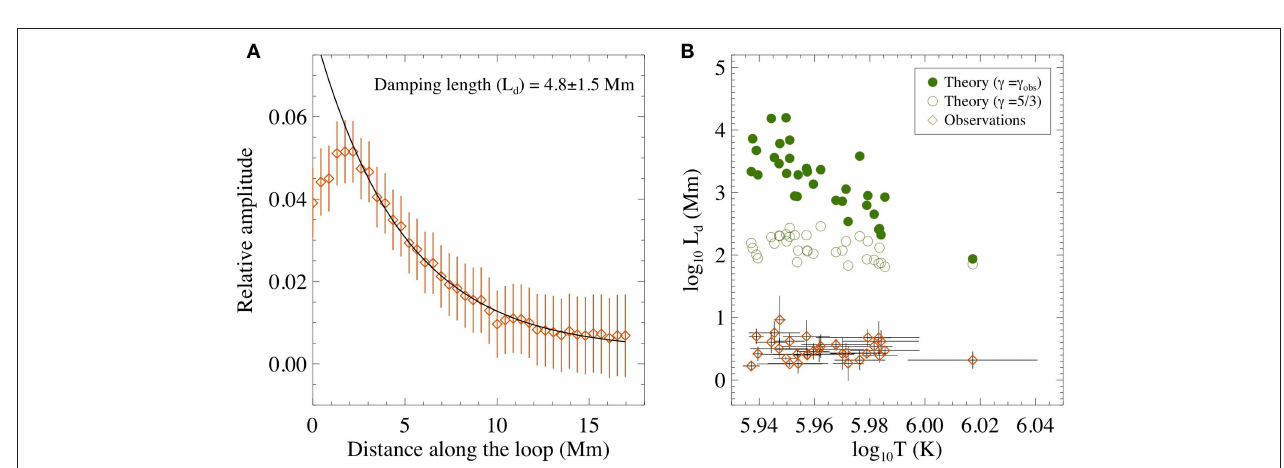
FIGURE 3 | (A) Relative amplitudes of the oscillations as a function of distance along the loop segment marked by the solid blue lines in Figure 1a . The vertical bars denote the respective uncertainties. The black solid line represents an exponential fit to the decaying phase of the data following Equation (2). The obtained damping length value from the fitted curve is listed in the plot. (B) Damping lengths extracted from all the selected loop structures plotted as a function of the local temperature on a log-log scale. The orange diamonds represent the observational values following the amplitude tracking method shown in (A) , whereas the green circles represent the theoretical values estimated from the damping due to thermal conduction. The open and filled circles, respectively, highlight the values computed from a constant γ ( 5 / 3) and those computed using γ values extracted from observations (Krishna Prasad et al., 2018). The vertical and horizontal bars on the observed = values denote the corresponding